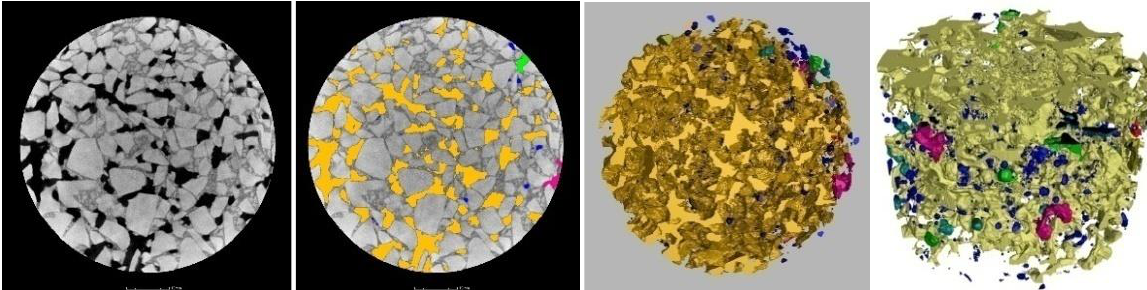
Figure 1. Three-dimensional reconstruction process of CT scan.